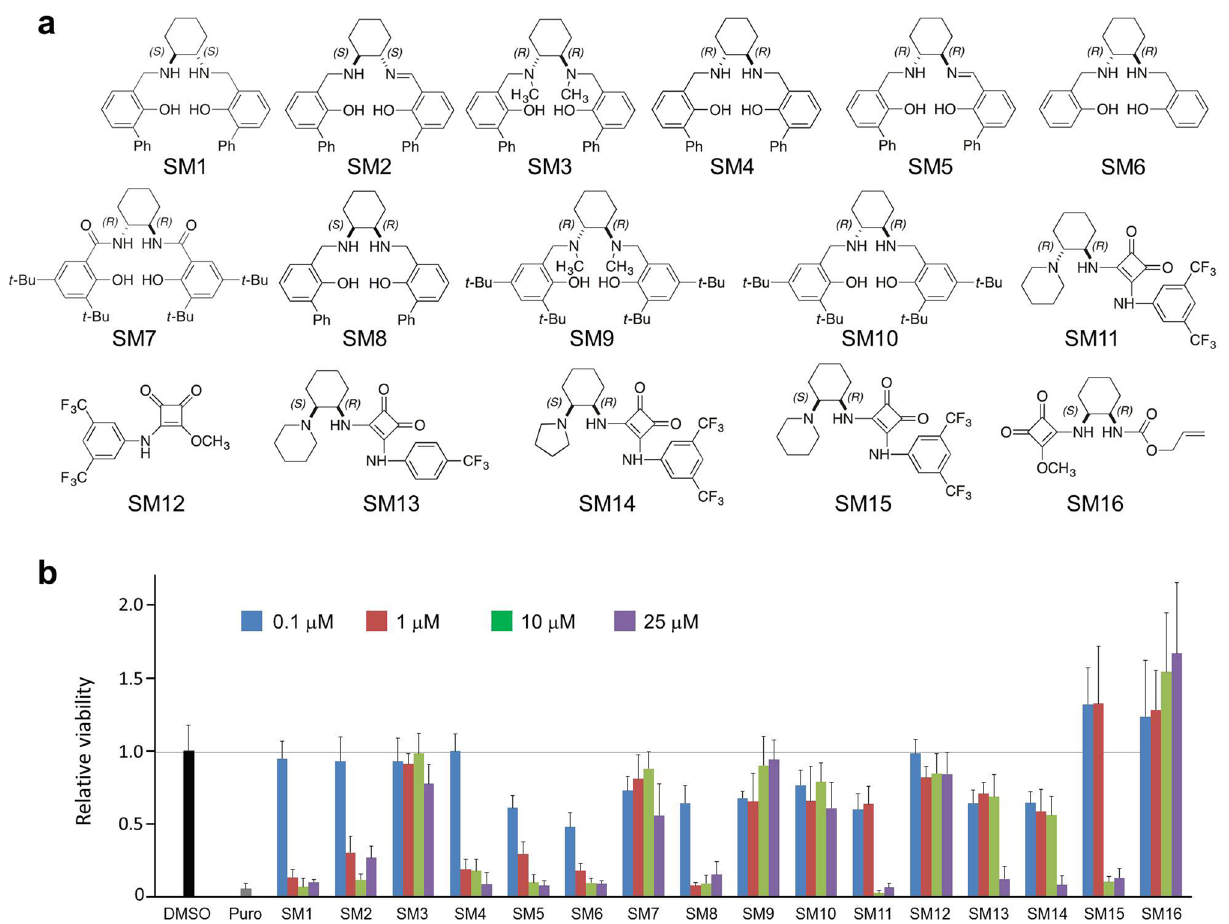
Figure 1. Toxicity of small molecules SM1-SM16 against miPSC line aPIG-AT25. ( a ) Chemical structures of 10 salicylic diamines (SM1-10) and 6 square amides (SM11-16) used in a cytotoxicity screen. ( b ) Relative viability of miPSCs after 48 h of treatment with the indicated concentrations of SMs (mean ± SD; n = 4). Control cells were treated with 0.125% DMSO or 8 μg/ml puromycin (Puro). Similar results were obtained in two additional independent